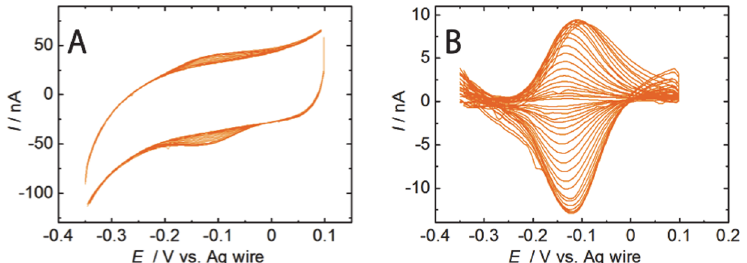
Figure 2. CVs of cyt c adsorbed on the electrode. (A) CVs of cyt c molecules adsorbed on the MUA electrode in a 10 mM phosphate buffer solution (pH 7.0) from 333 to 522 s (from − 0.35 V to 0.1 V, each segment is 4.5 s). (B) Background-subtracted CVs from the voltammogram from 313 to 324 s and 333 to 522 s (from inside to outside, each segment is 4.5 s). The voltammograms were collected at a scan rate of 100 mVs − 1 . Ag wire was used as a reference